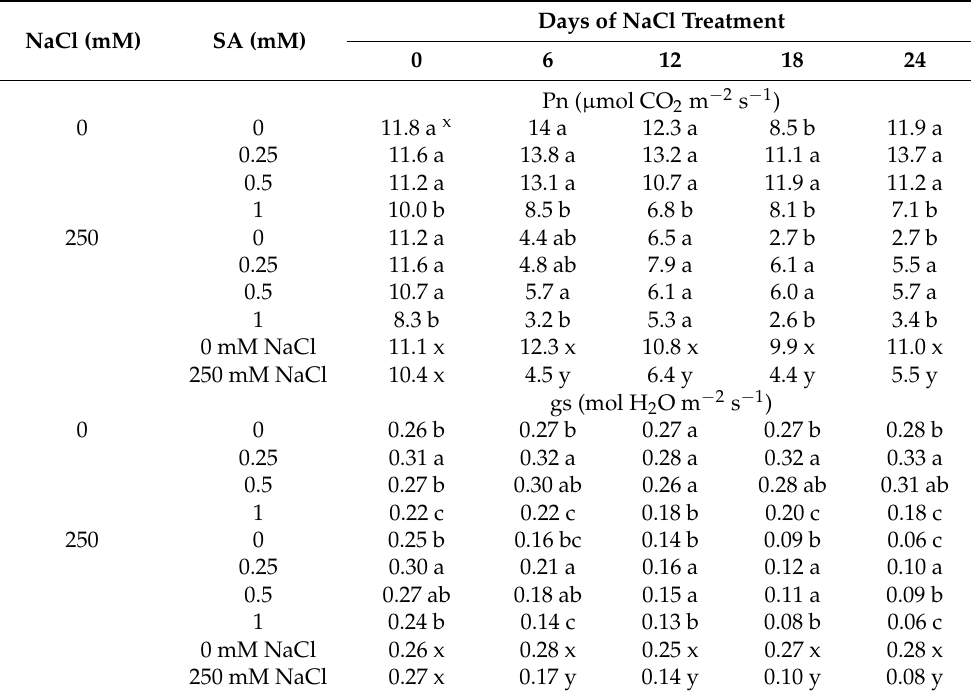
Table 3. Effect of salicylic acid on photosynthetic rate (Pn) and stomatal conductance (gs) of perennial ryegrass under two salt